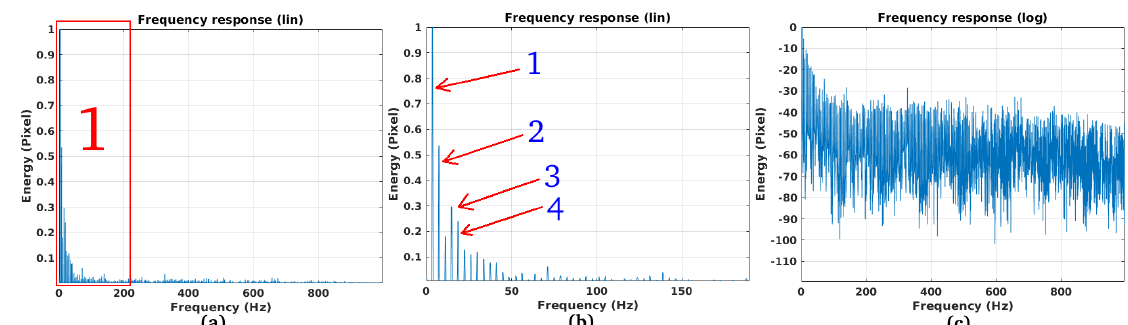
Figure 6. Temporal trend of vibrations.